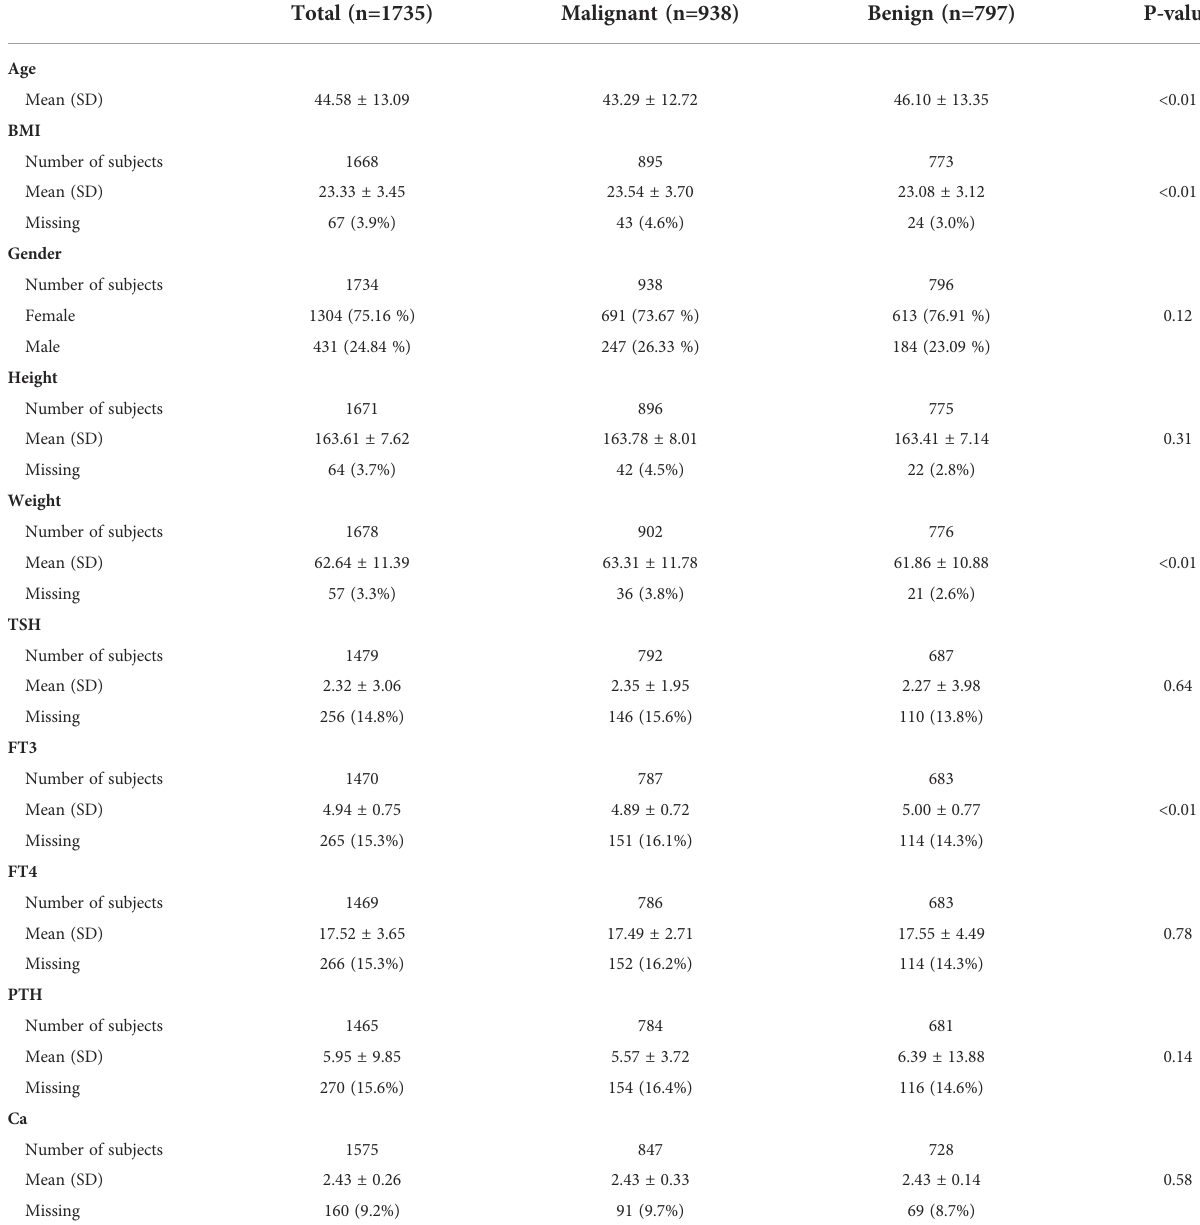
TABLE 1 Baseline characteristics of included